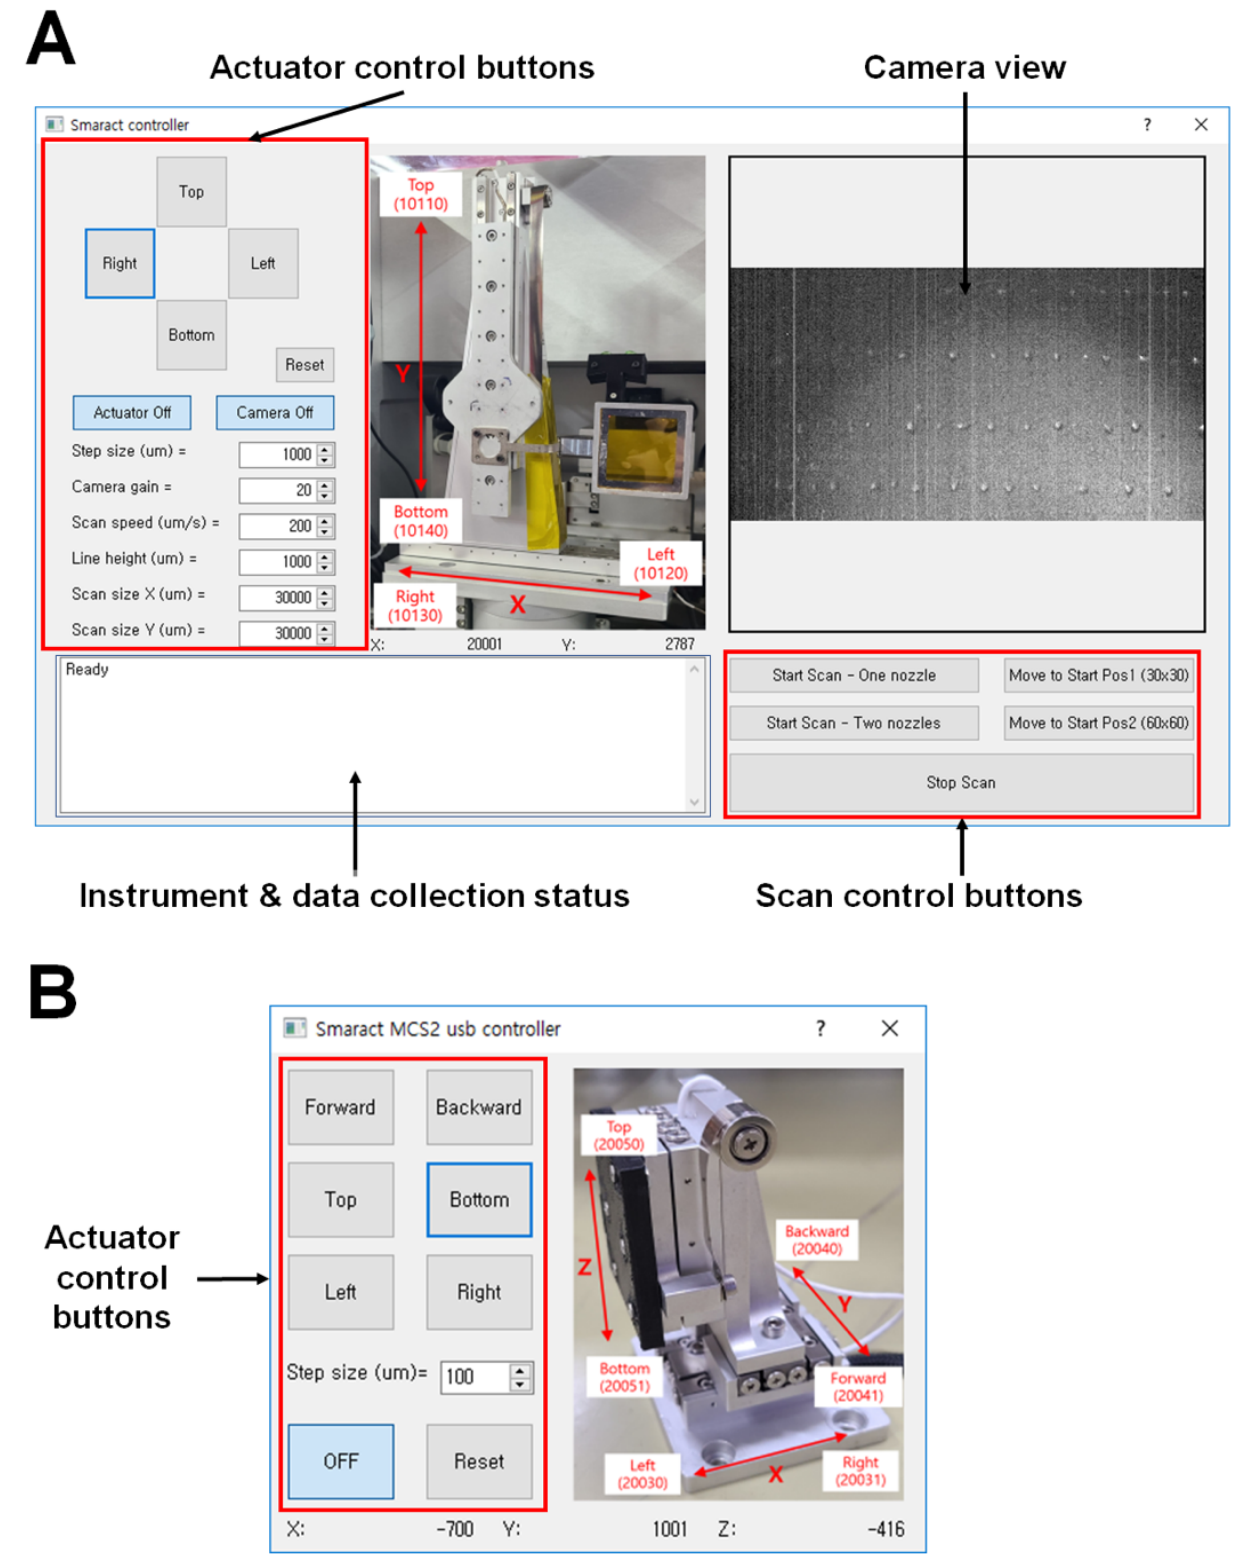
Figure 2. BITS control software GUI. GUI programs for ( A ) fixed-target control and ( B ) syringe needle position control.